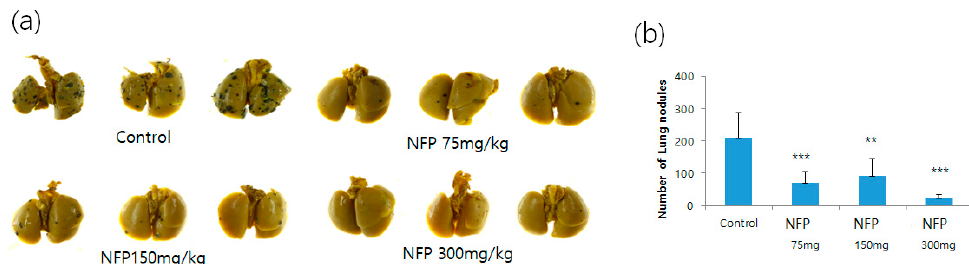
Figure 4. Effects of NFP on the lung metastasis of B16F10 melanoma cells in vivo. ( a ) Photographs of lung colonization in C57BL/6 mice orally administered with NFP at doses of 75, 150 and 300 mg/kg/day, compared with the vehicle control group. ( b ) Quantitative analysis of lung nodules of B16F10 melanoma cells. Data represent the mean-standard deviation (SD) ( n = 6). Statistical significance of differences between the vehicle control and NFP treatment groups was evaluated using Student’s t-test (* p < 0.05, ** p < 0.01, *** p < 0.001).